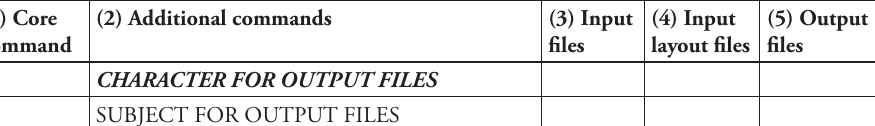
Table 7. Classifi cation of commands used in the ofi les directive fi le. Reference numbers used in Fig. 34 are given in the header of the table. Th e command in bold and italics may require changes being made by the